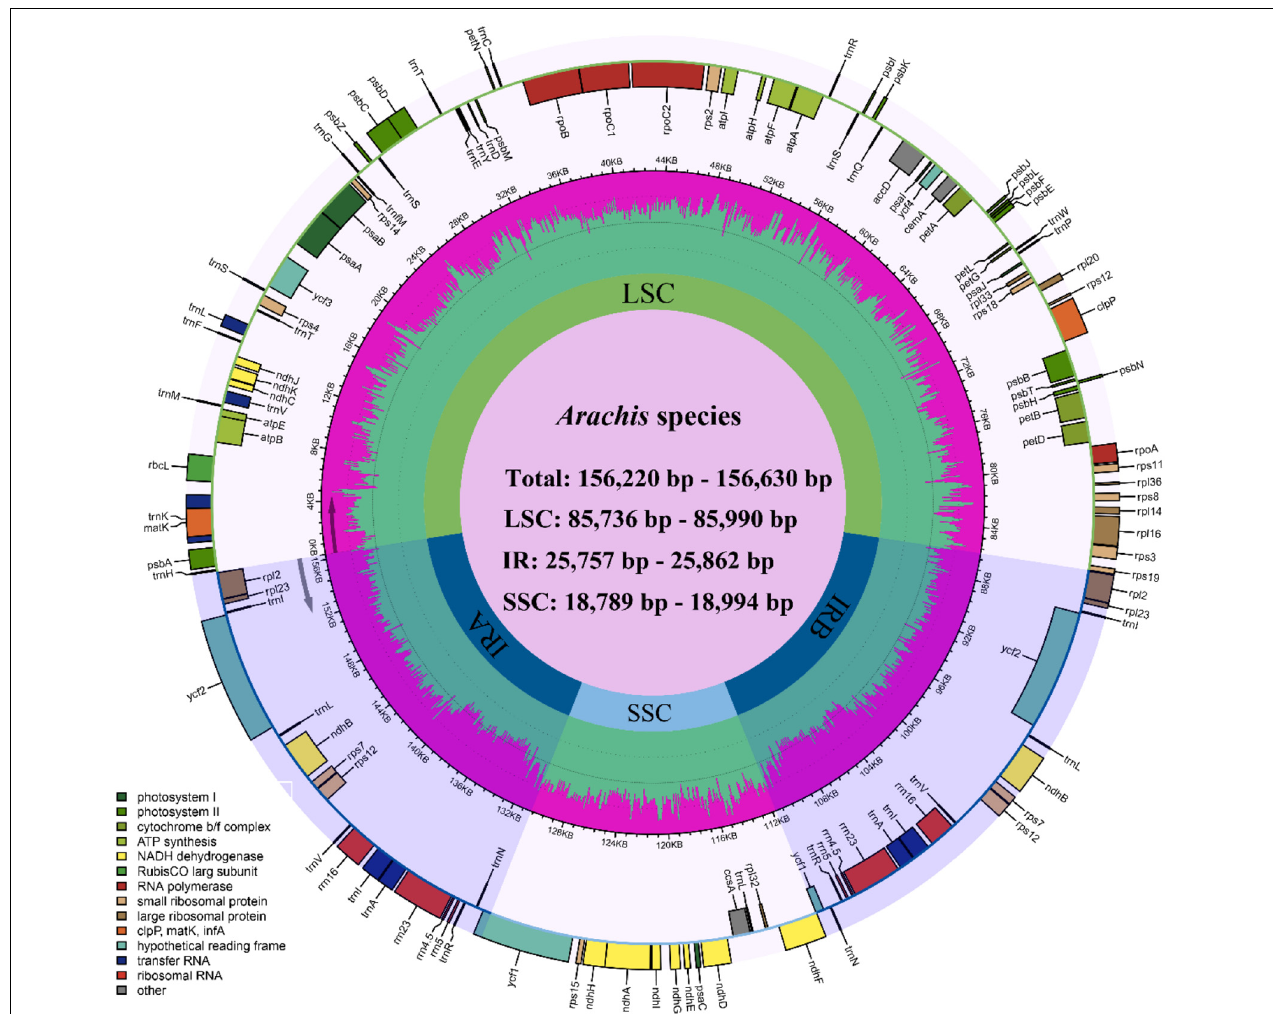
FIGURE 1 | Circular plastome map of Arachis . Genes of different functional groups are color coded. The green in the inner circle corresponds to the GC content, while the pink corresponds to the AT